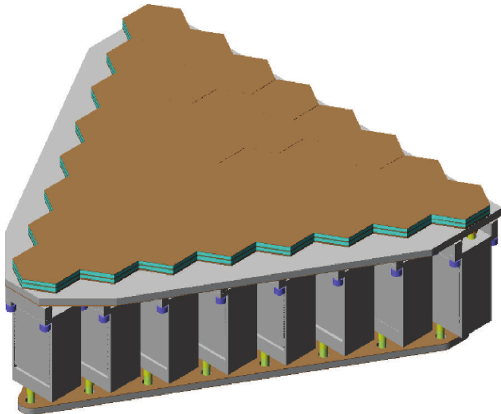
Figure 11: Tile of the hemi-spherical